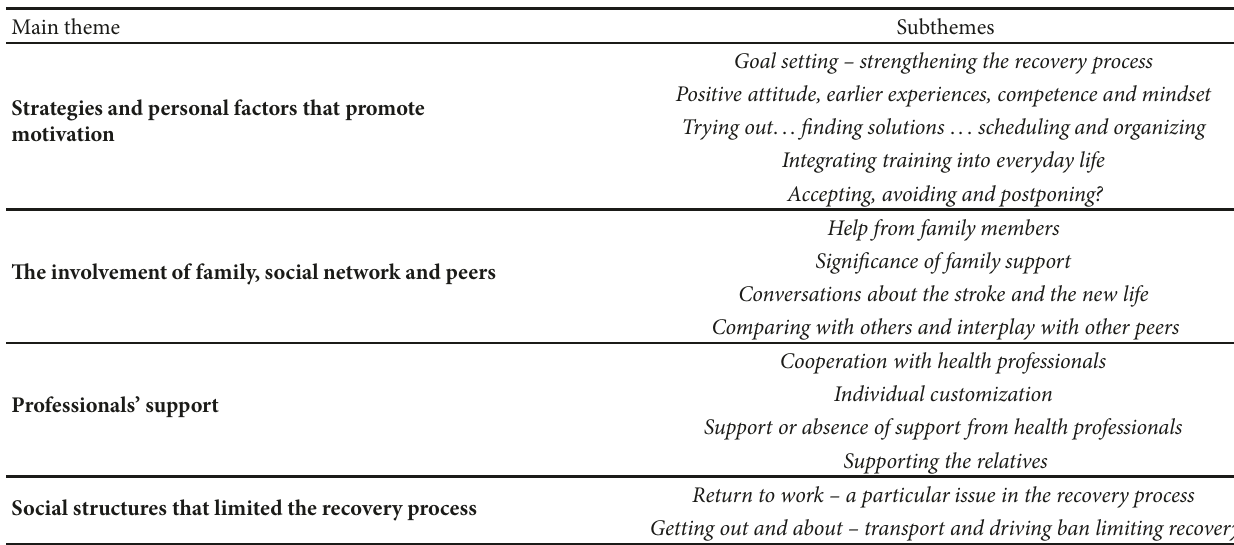
Table 3: Ways to overcome and manage altered